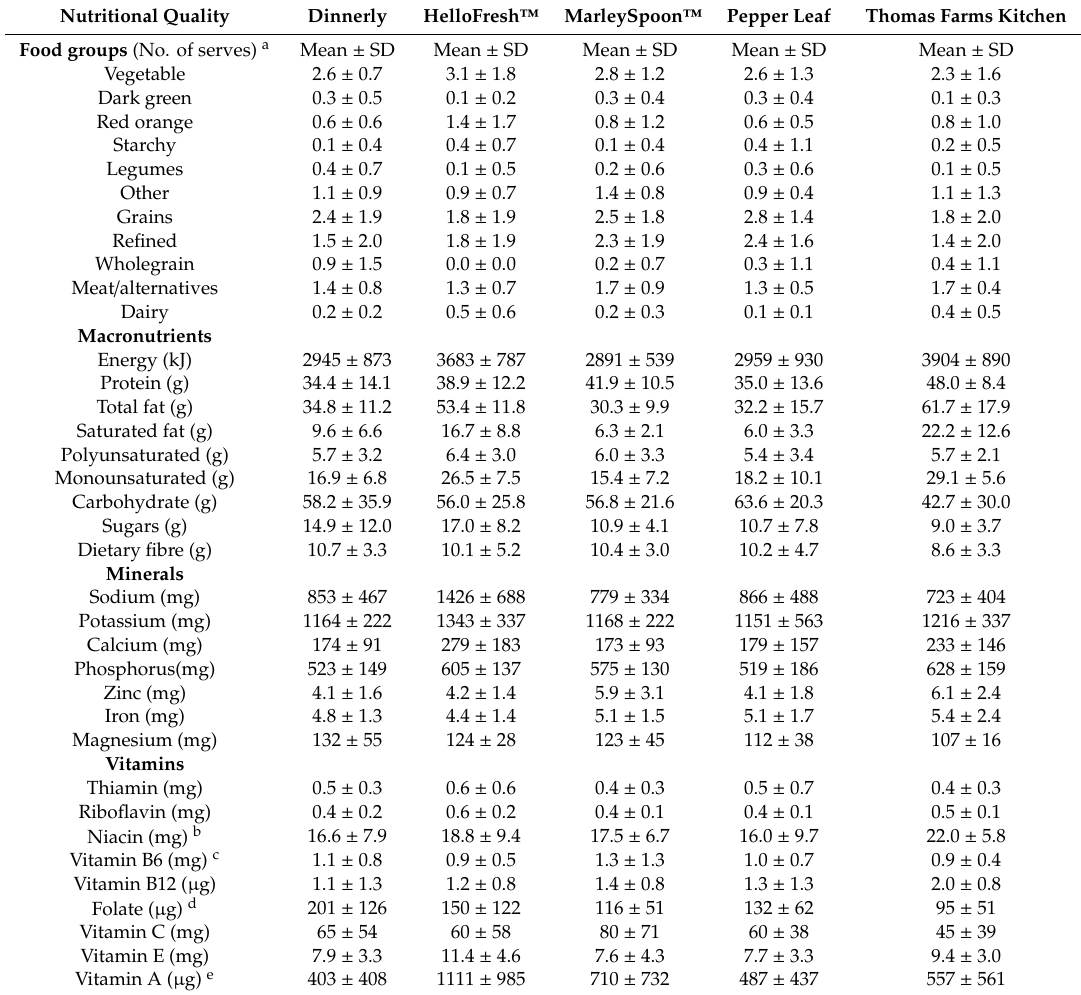
Table 2. Comparison of the average nutritional qualities per serve from 12 recipes from each of the five meal kit subscription services.